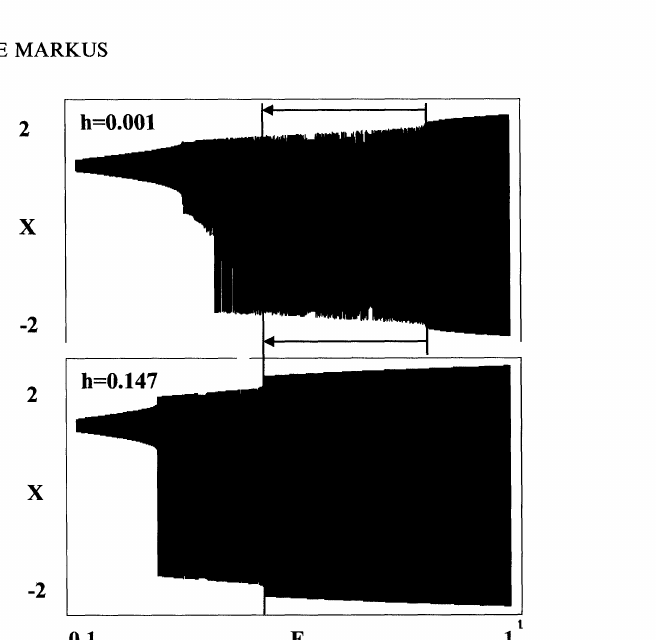
FIGURE 3 Bifurcation plots as a function of the amplitude of the driving force for the Dutting oscillator (3), integrated with a standard forward Euler scheme with step size h 0.001 and h 0.147. Arrows indicate the suppression of chaos by the advance of a numerically induced periodic front.